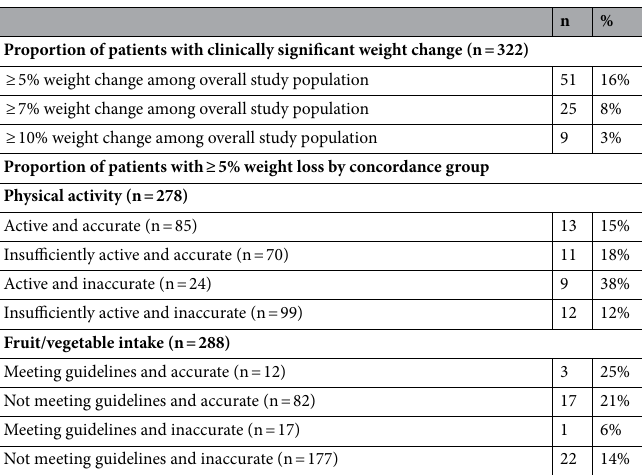
Table 6. Weight change from baseline to follow-up. Median follow-up time was 15 months; of the 322 patients with available follow-up weight, 278 had self-perception and physical activity data, and 288 had self-perception and fruit/vegetable intake